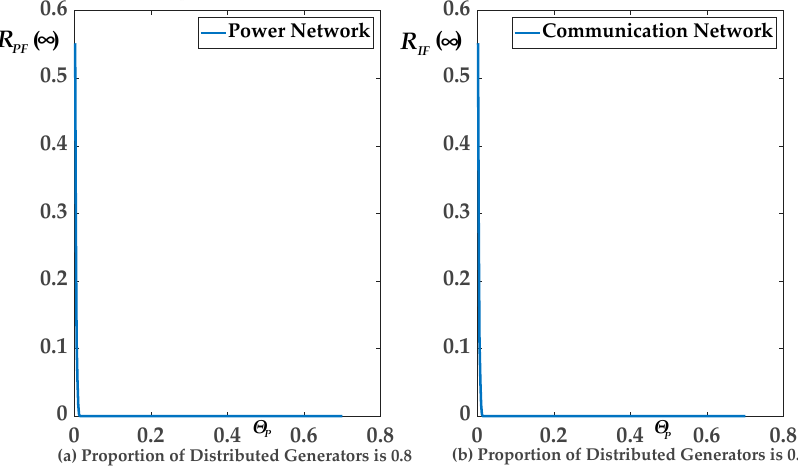
Figure 6. R PF ( ∞ ) of di ff erent distributed generators proportions in the PN with Barabasi–Albert (BA)topological structure.